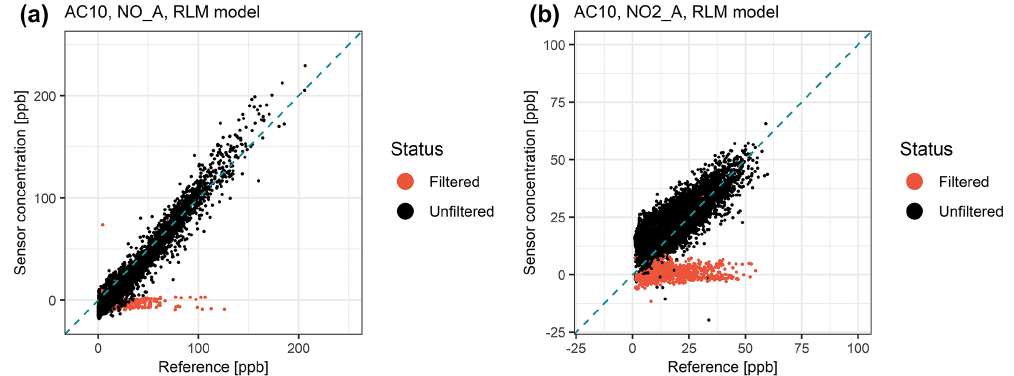
Figure 9. Scatter plots of sensor concentrations calibrated using the RLM model versus reference measurements during the second co- location period for (a) NO and (b) NO 2 from AC010 (10min values). Sensor malfunctioning periods were visually identified and filtered (red dots). Similar scatter plots for the other sensor units can be found in Figs.